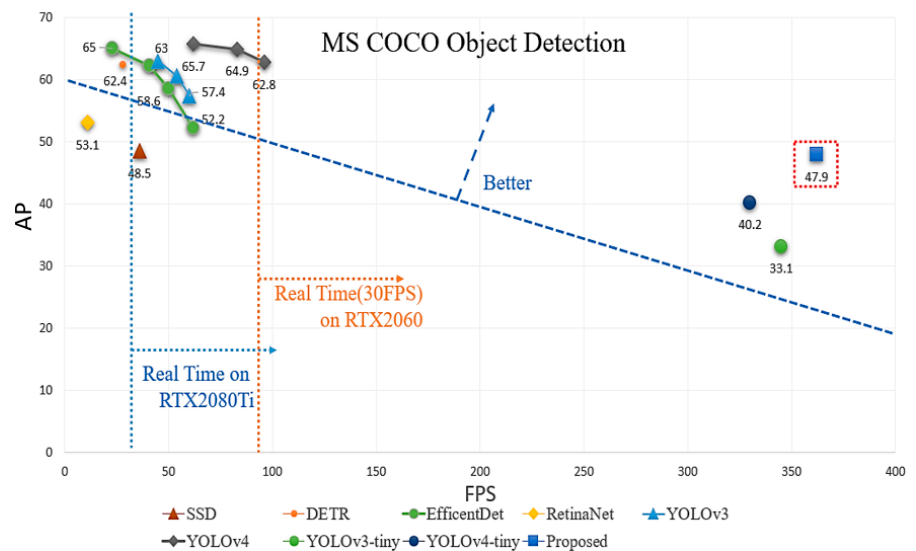
Figure 1. Comparison of average prediction (AP) accuracy with respect to the frame processing speed (FPS) against the state-of-the-art methods. SSD [17], EfficientDet [19], Retina Net [26], DETR [27], YOLO v3 [14], v3-tiny [15], v4 [16], v4-tiny [23].